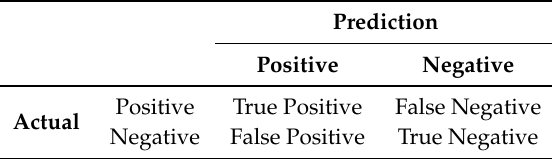
Table 3. Confusion matrix for binary classification.